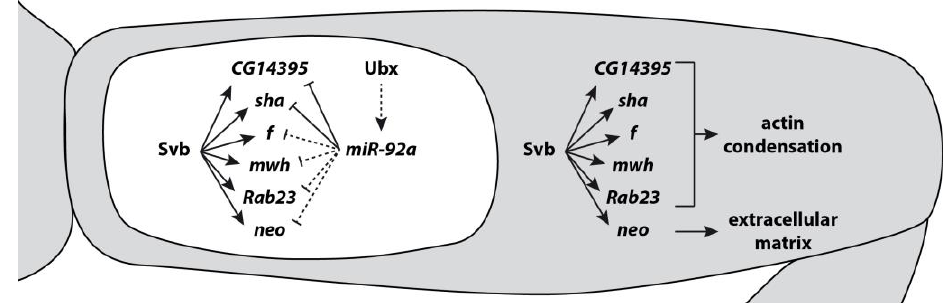
Figure 2. Trichome formation on Drosophila legs is repressed by miR-92a . The TF Shavenbaby (Svb) controls the expression of multiple genes whose products lead to the formation of trichomes (grey) via promotion of actin condensation and changes in the extracellular matrix. Some of these genes ( sha and CG14395 ) have been shown to be repressed by miR-92a , and others are likely targets. The targeting of these genes by miR-92a results in a robust suppression of trichome development in the proximal region of the second leg femur where miR-92a is expressed (the naked valley; white). miR-92a expression is possibly activated by Ubx.